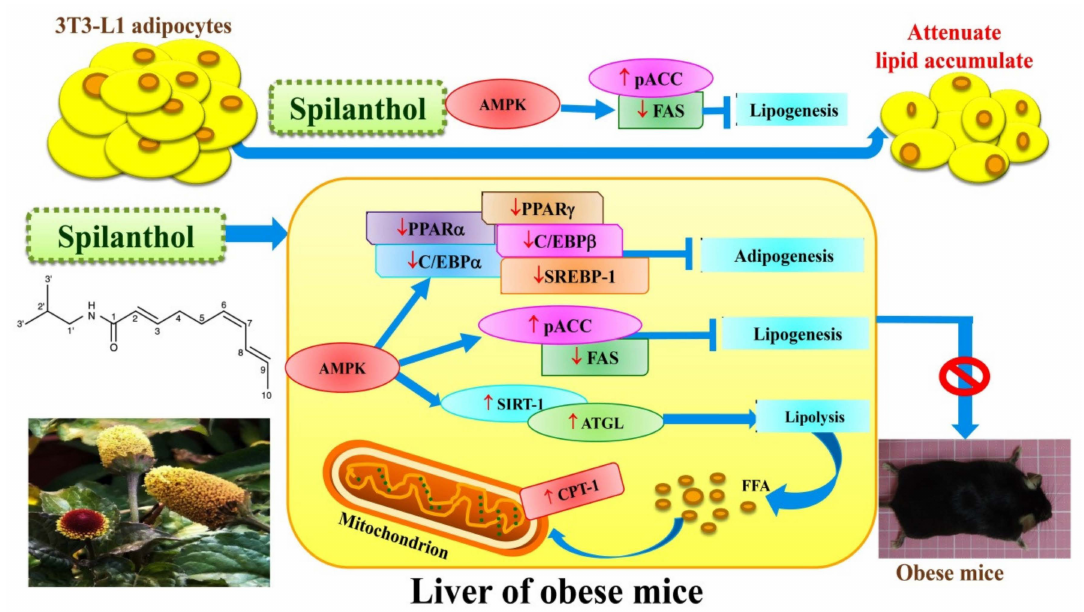
Figure 9. Model explaining the mechanism underlying the anti-obesity e ff ects of spilanthol (SP). SP increases lipolysis-related proteins, suppresses the protein expression of adipogenesis-related transcript factors, and reduces lipogenic proteins via activation of AMPK in the liver of obese mice. SP also inhibits lipogenesis to reduce ACC and FAS expression in 3T3-L1 adipocytes. SP is a potential anti-obesity compound that could ameliorate liver lipid accumulation in obese